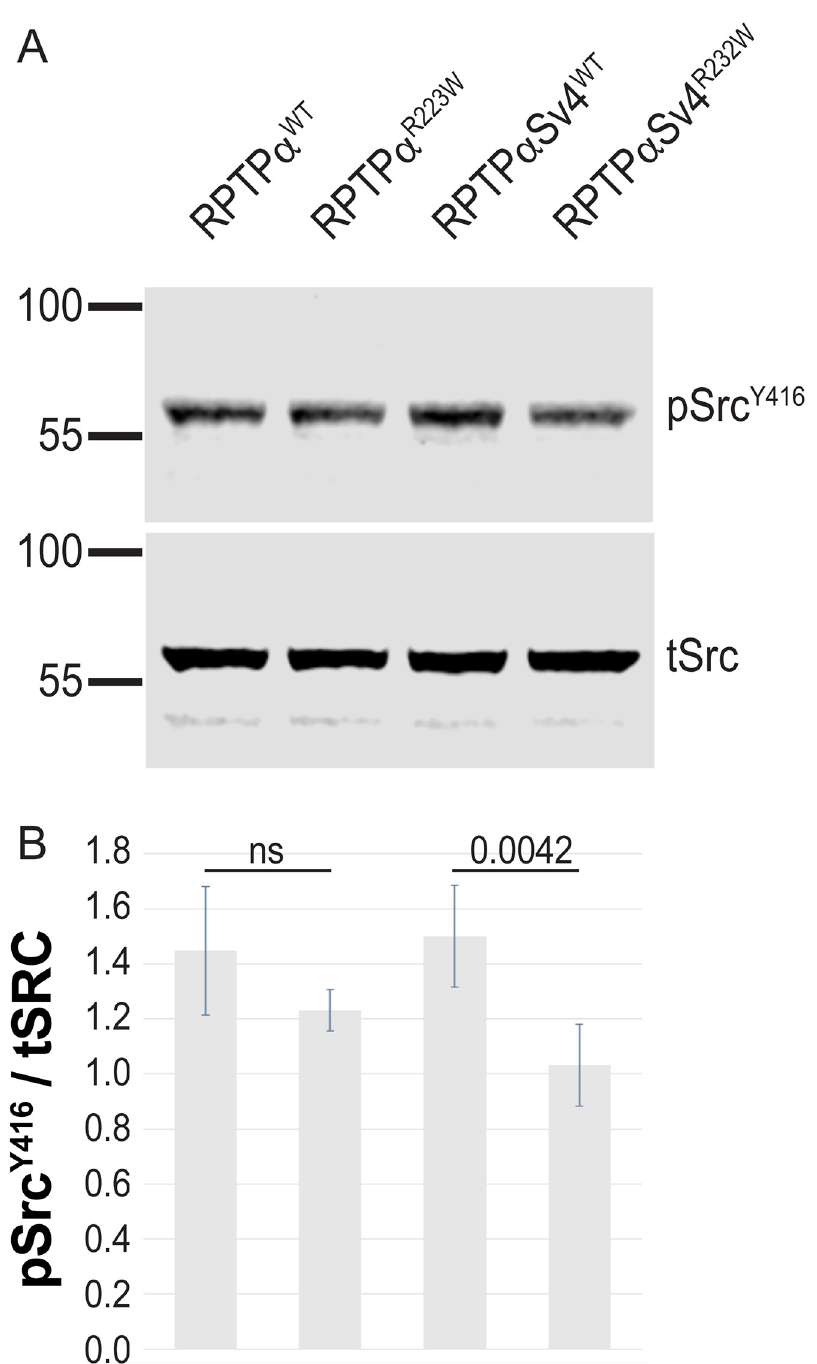
Fig 5. (A) Immunoblots of HEK293 stable cells expressing RPTP α WT , RPTP α R223W , RPTP α -Sv4 WT and RPTP α - Sv4 R232W and probed with the labelled antibodies. (B) Quantification of the ratio of pSrc Y416 signal in RPTP α mutants compared to their respective RPTP α WT (mean ± SD, n =